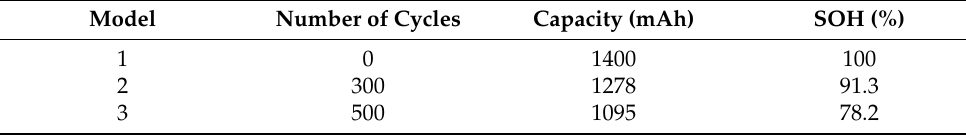
Table 1. Battery capacity and SOH values for the three cycle